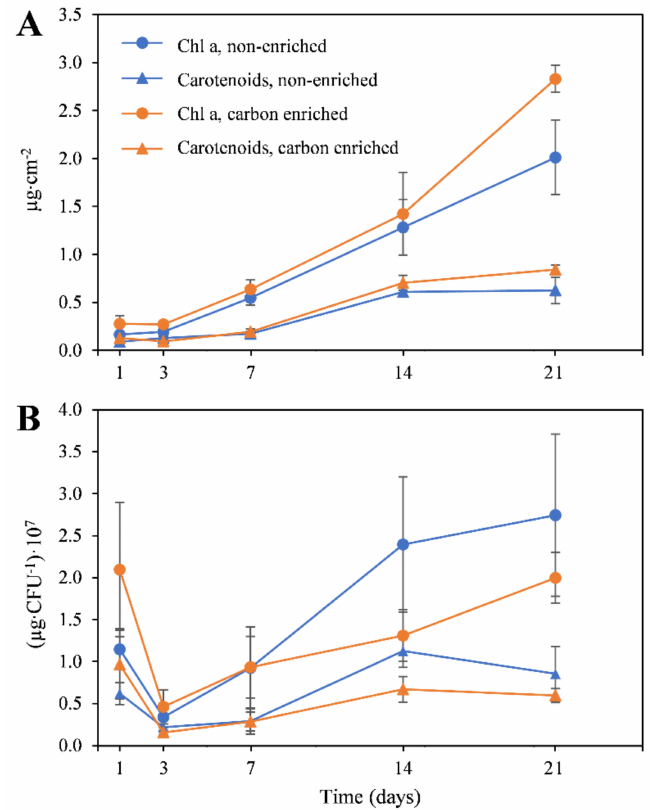
Figure 4. ( A ) Photosynthetic pigments concentration on granite surface and ( B ) photosynthetic pigments production per cell in biofilms grown in non-enriched medium and in medium enriched with inorganic carbon. Data are expressed as mean values of three independent replicates (error bars indicate standard deviations).